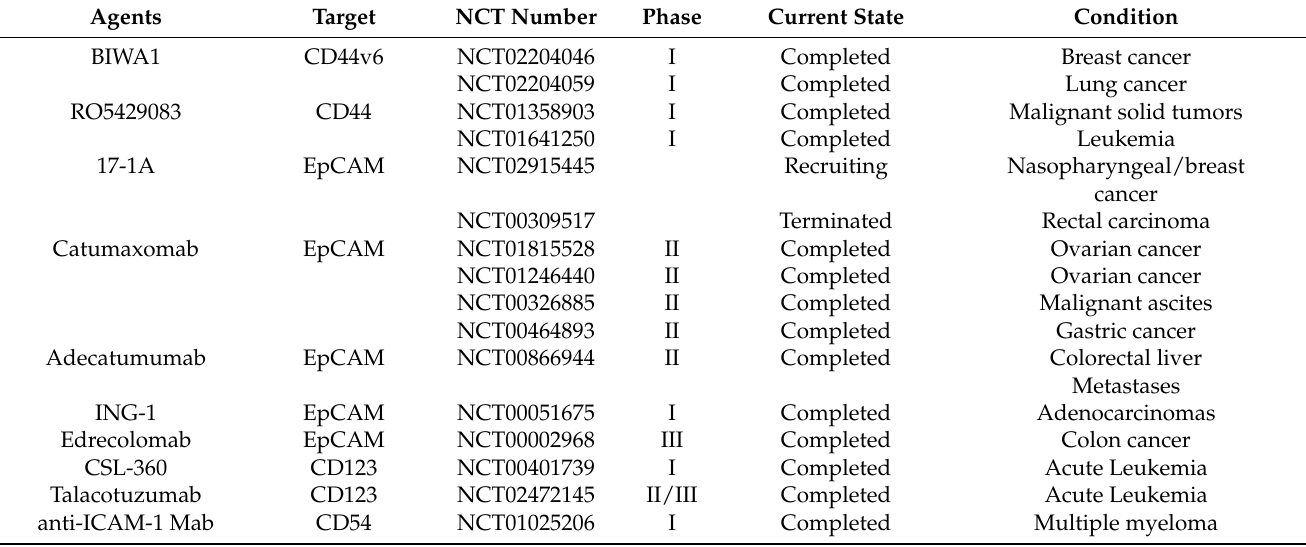
Table 1. Some agents targeting surface markers of CSCs which have been evaluated in clinical trials. Agents